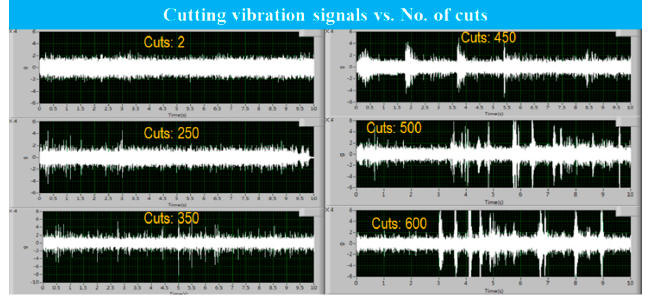
Figure 7. Cutting vibration vs. number of cuts for machining process T03.